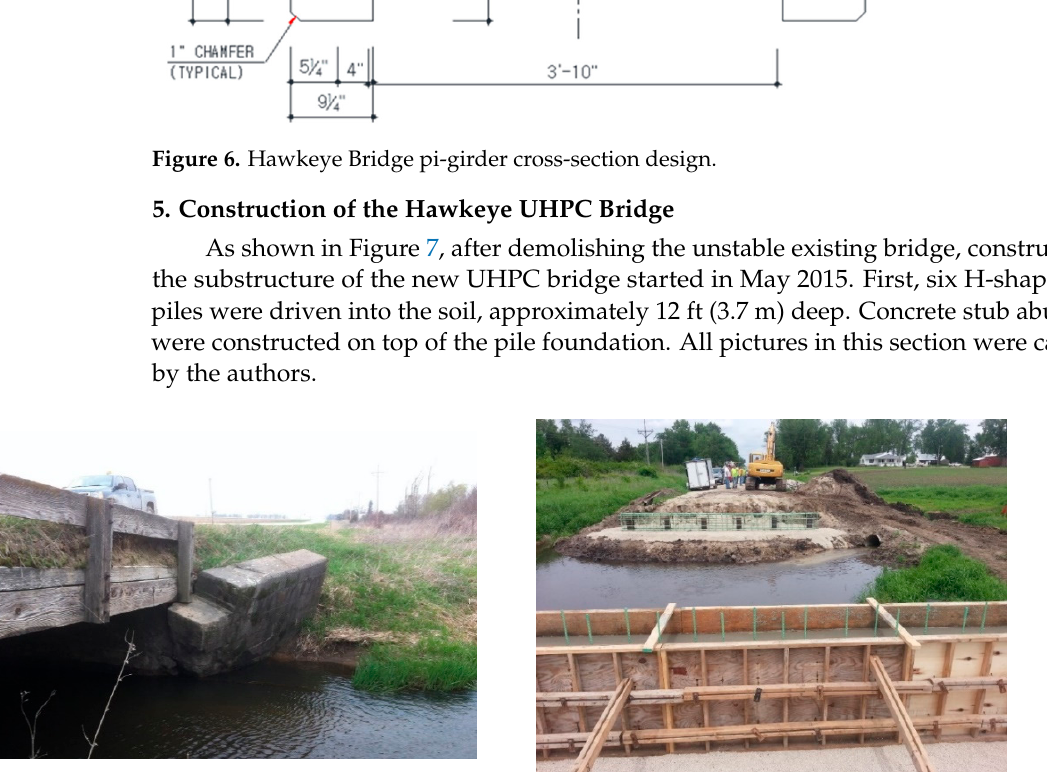
Figure 7. Existing unstable bridge ( left ) and construction of substructure of new UHPC bridge ( right ).